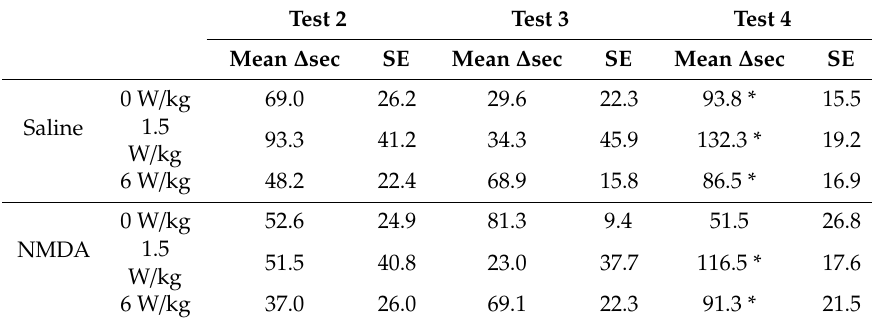
Table 2. Heat avoidance ( ∆ 28–50 ◦ C sec) on the 2nd, 3rd and 4th tests. Sham-exposed